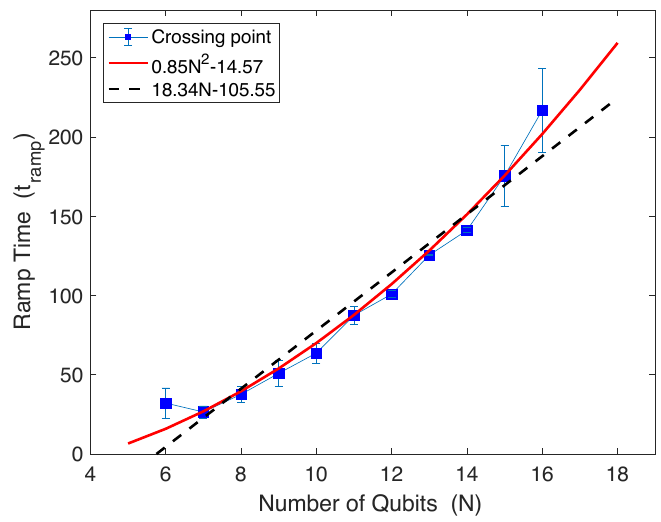
Figure 12 . The blue dots represent the estimates of the ramp time from the crossing point of the intermediate region power law (cid:12)t and the linear (cid:12)t to the ramp. The error bars illustrate the di(cid:11)erence between this estimate and the ramp estimate using an error of (cid:15) = 20%. The best (cid:12)t is given by the red parabola and the alternative, linear (cid:12)t is show as a black dashed line.